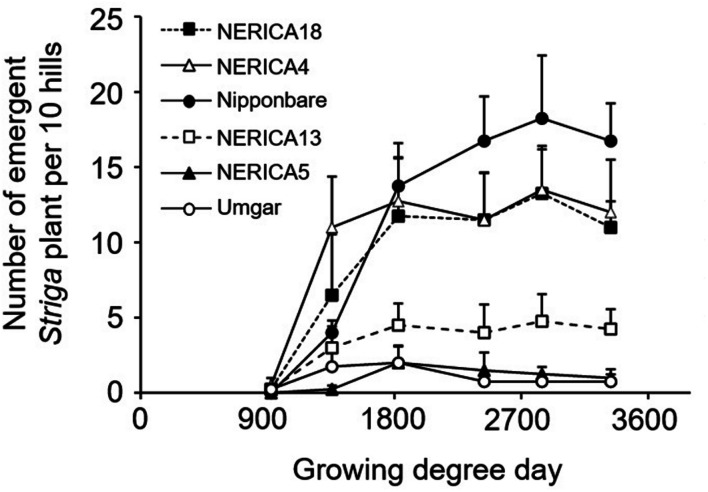
Number of emergent S. hermonthica plants per 10 rice hills in an artificially infested field. Umgar, NERICA5, NERICA13, Nipponbare, NERICA4, and NERICA18 were used in a semi-controlled open air experiment. Bars indicate standard errors of each mean value of four replications.